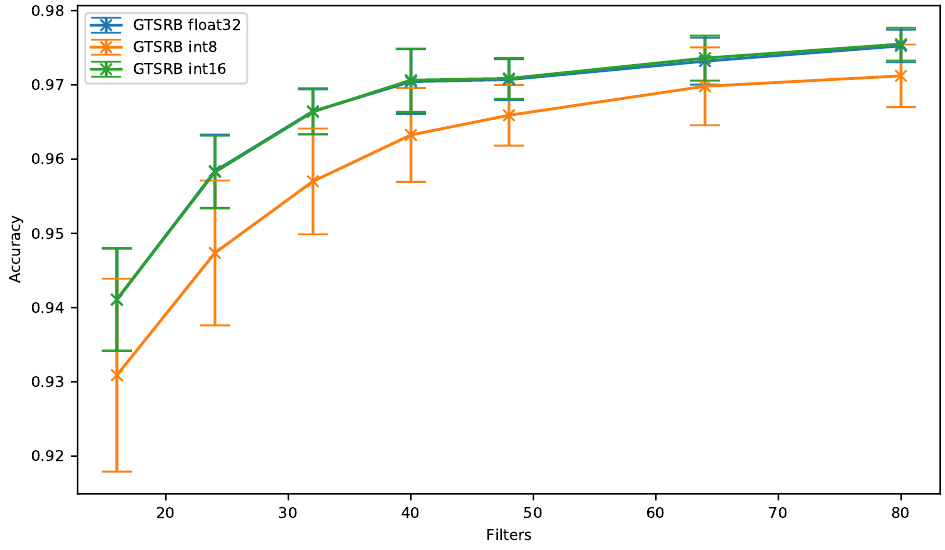
Figure 9. German Traffic Sign Recognition Benchmark: accuracy vs.